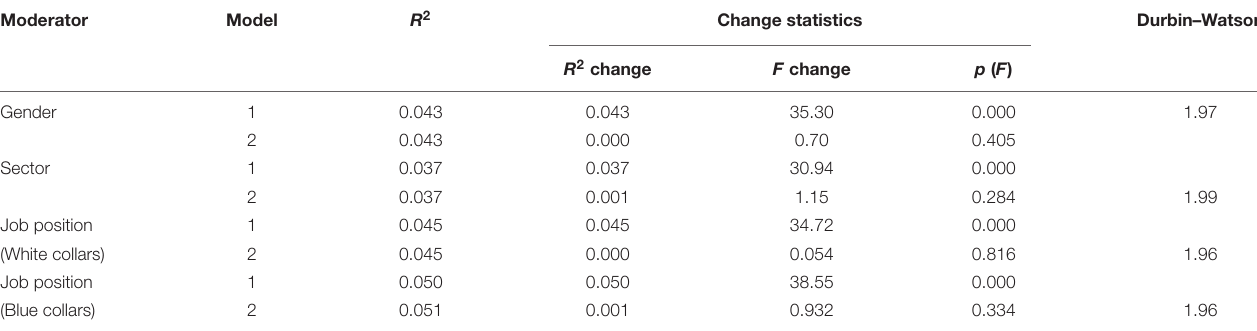
TABLE 3 | Regression results for mediation.